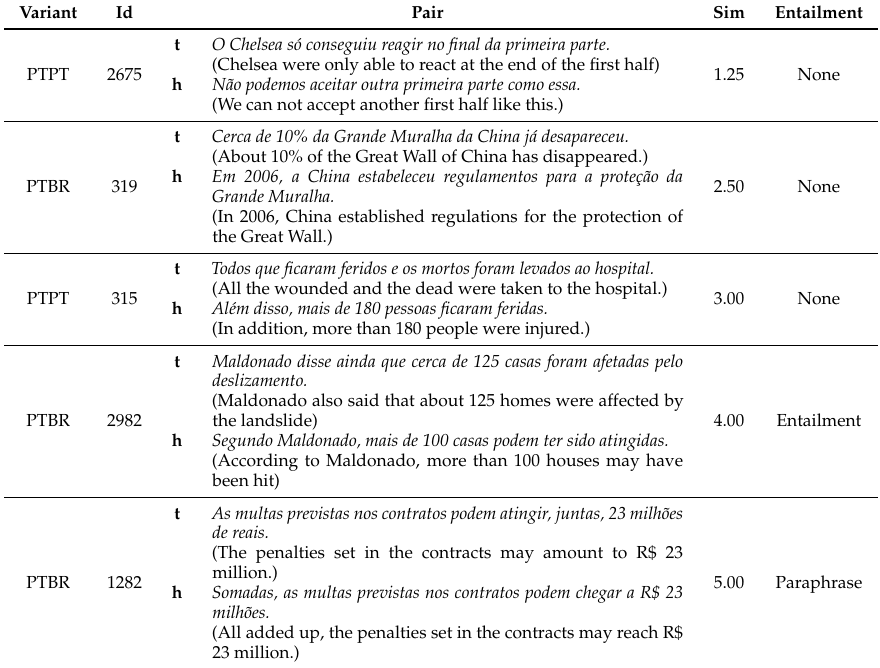
Table 16. Selected examples from the ASSIN training collection, for EurOpean Portuguese (PTPT) and for Brazlian Portuguese